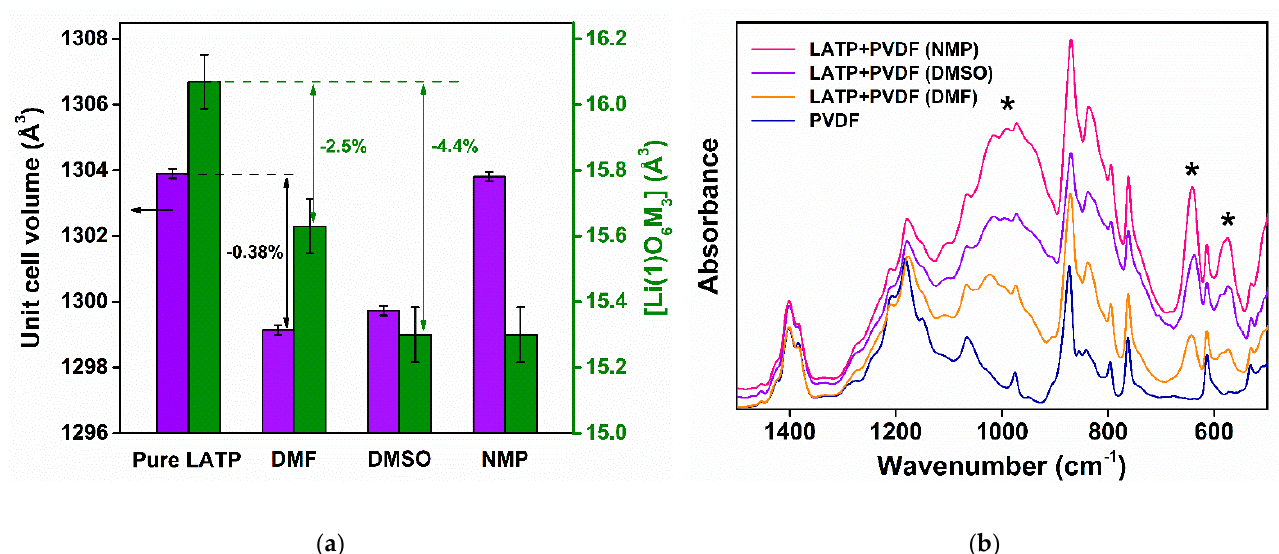
Figure 5. ( a ) Calculated unit cell and [Li(1)O 6 M 2 ] polyhedra volumes of the ceramic (pure LATP) and that within the LATP+PVDF composite membranes cast with DMF, DMSO, and NMP; ( b ) ATR − FTIR spectra of PVDF powder and LATP+PVDF membranes cast with the studied solvents. Signals of LATP are marked with asterisks.